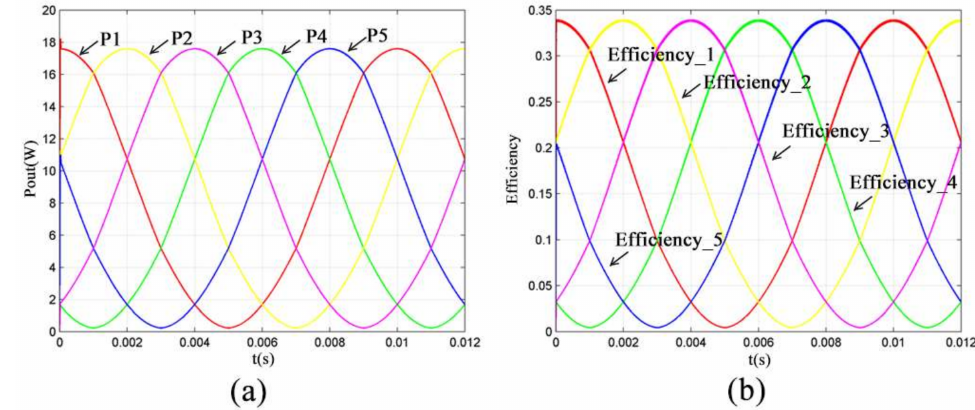
Figure 11. Waveforms of the output power and transfer efficiency against time in the five-receiver system: ( a ) output power; ( b ) transfer